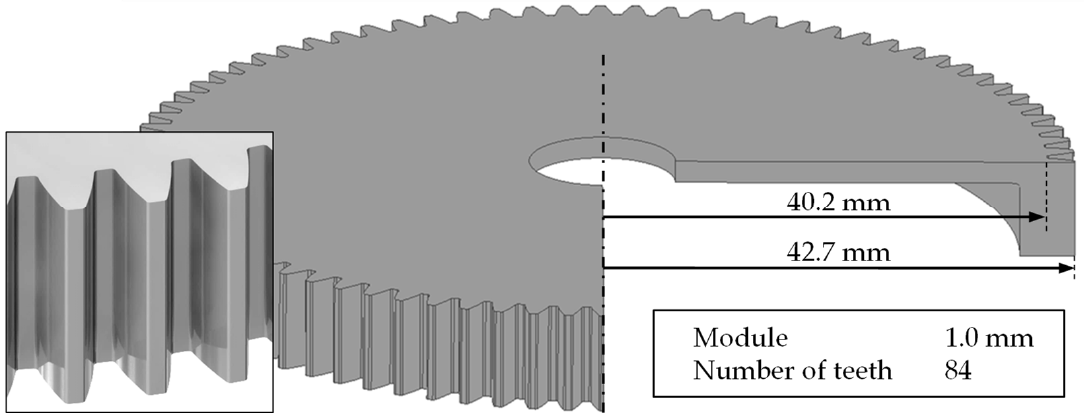
Figure 3. Investigated component geometry.